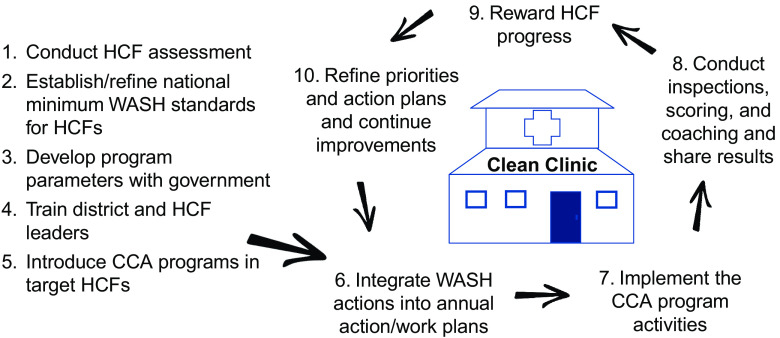
10-Step Clean Clinic Approach for WASH Quality ImprovementsAbbreviations: CCA, Clean Clinic Approach; HCF, health care facility; WASH, water, sanitation, and hygiene.